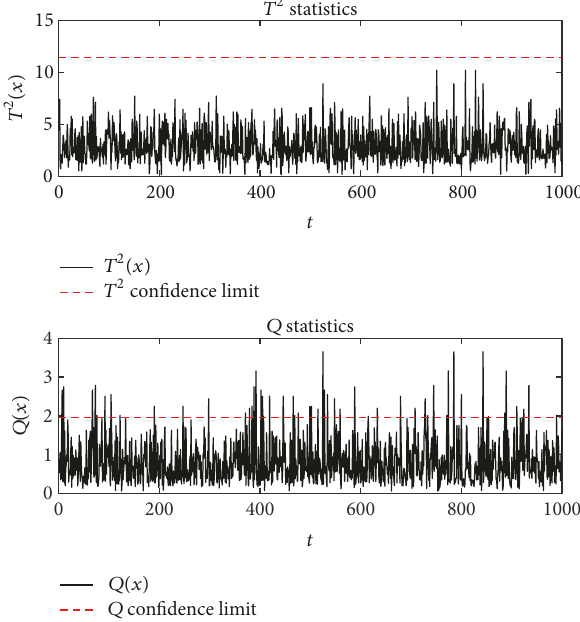
Figure 2: 𝑄 and 𝑇 2 statistics with original